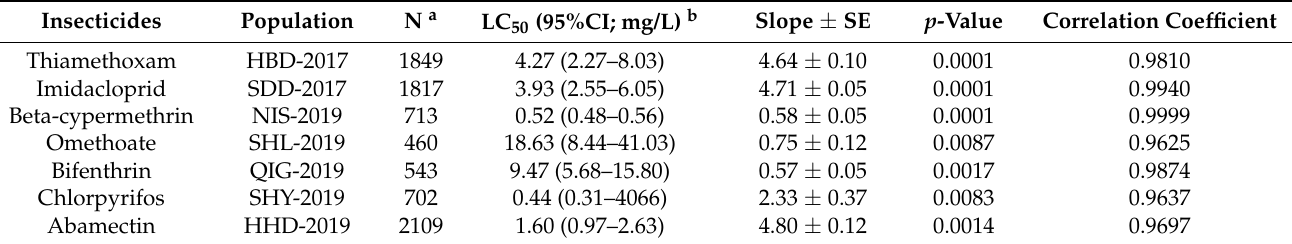
Table 2. Susceptibility baseline of Metopolophium dirhodum to seven